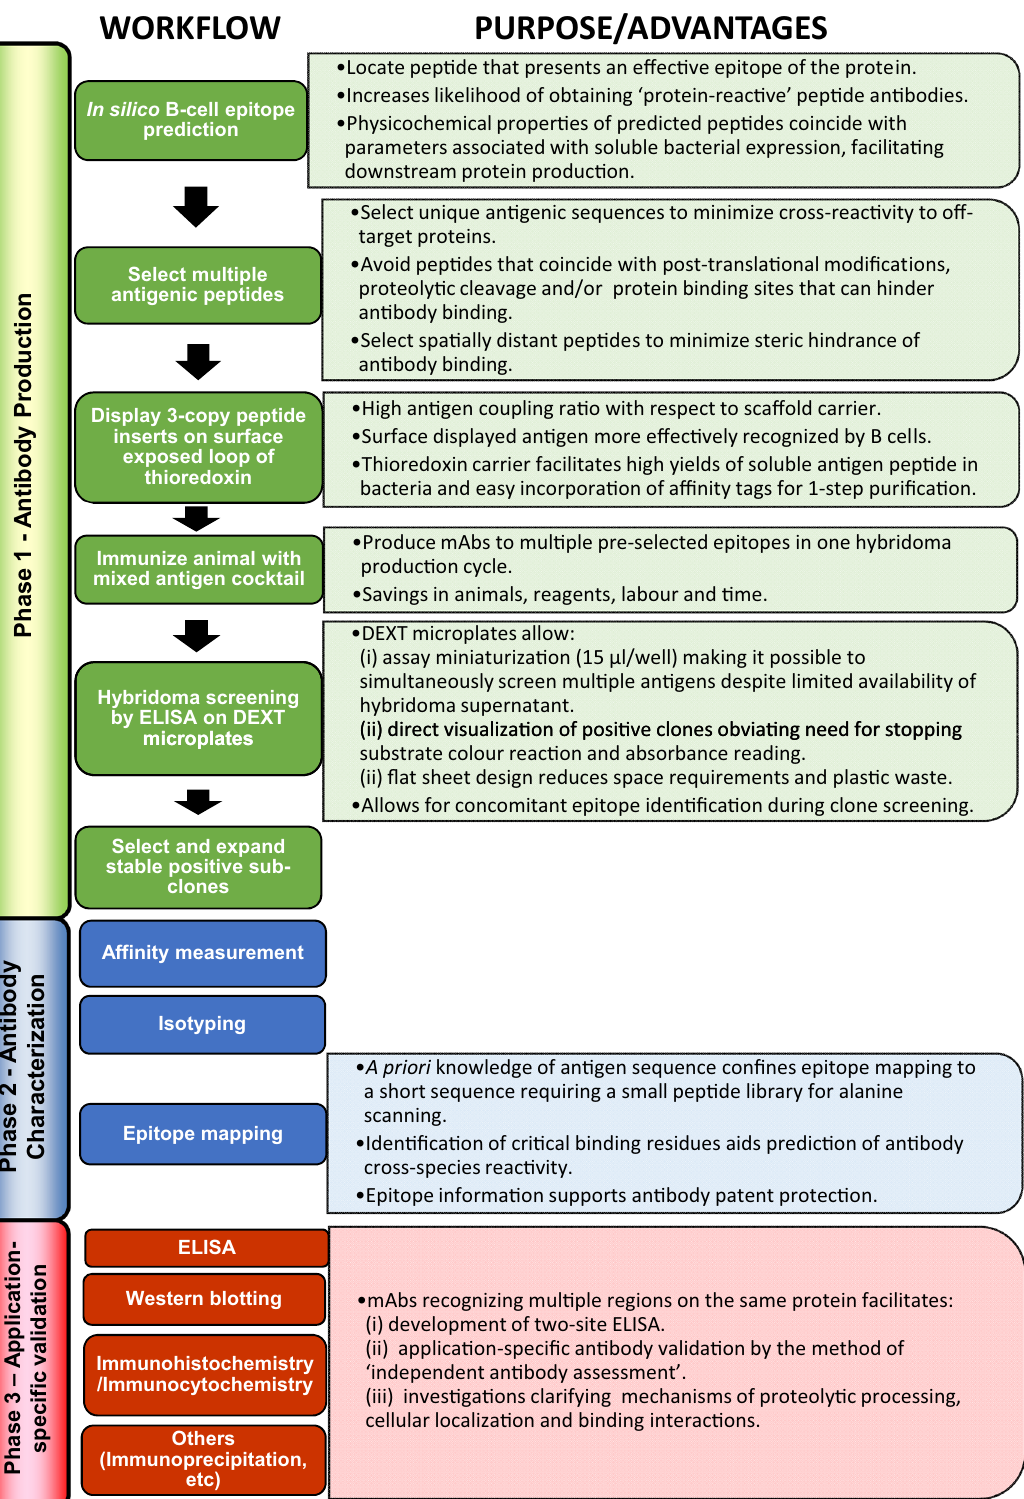
(iii) inves(cid:2)ga(cid:2)ons clarifying mechanisms of proteoly(cid:2)c processing, cellular localiza(cid:2)on and binding interac(cid:2)ons.